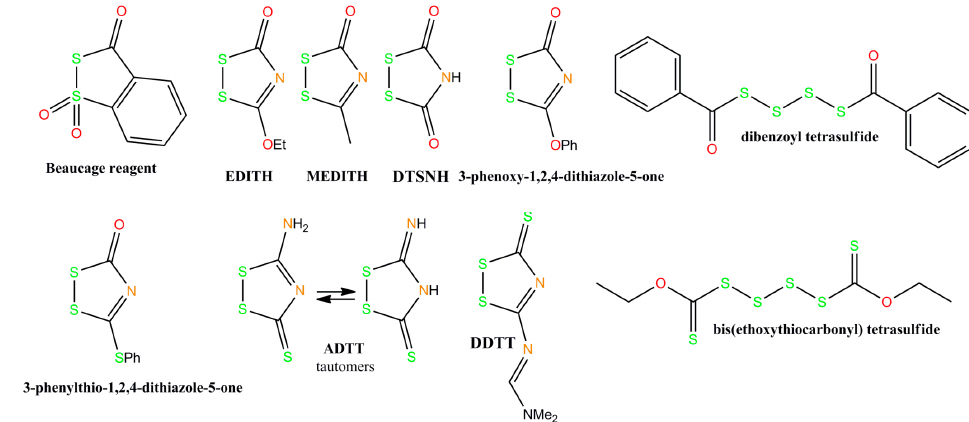
Figure 1. Chemical structures of selected oxidative sulfurization reagents. EDITH: 3-ethoxy-1,2,4-